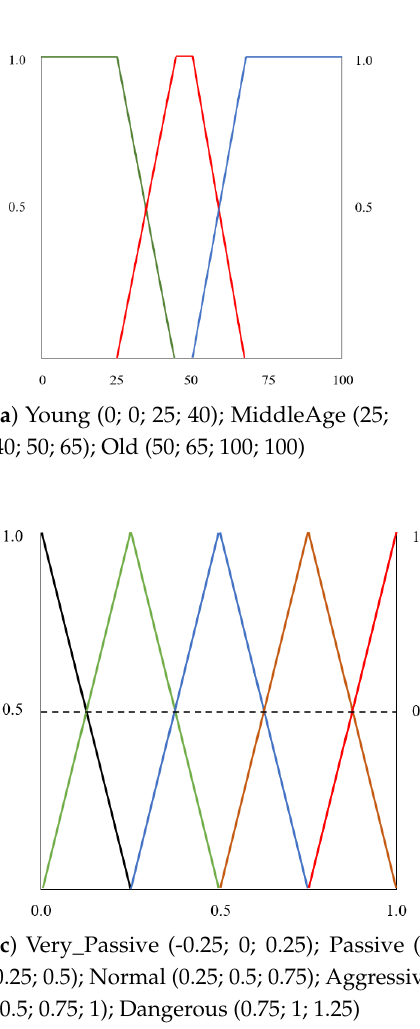
Figure 5. Definition of membership functions and fuzzy sets. ( a ) Trapezoidal membership functions and fuzzy sets representing the age. ( b ) Five equally spaced triangular-shaped membership functions and fuzzy sets representing acceleration and braking. ( c ) Five equally spaced triangular-shaped membership functions and fuzzy sets representing the driver